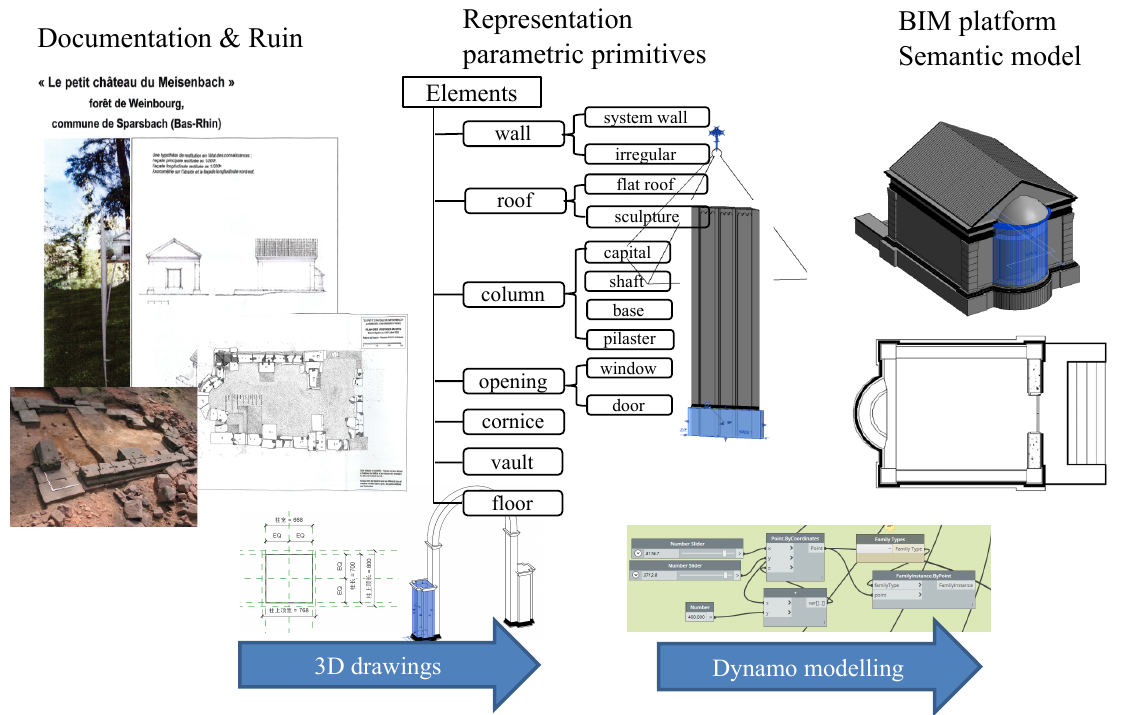
Fig. 1. Workflow from documentation recording to parametric elements and BIM model